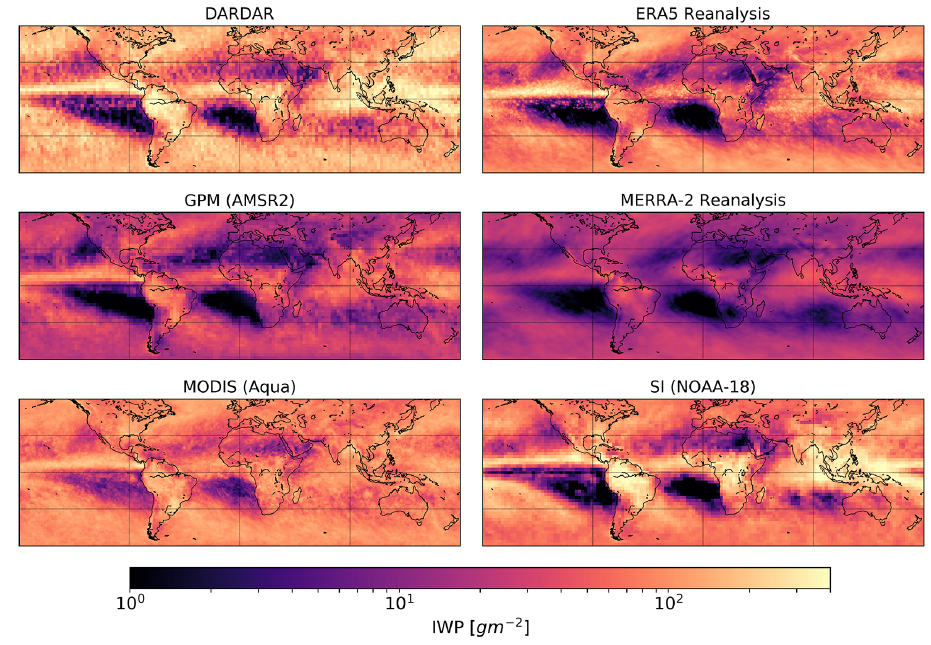
Figure 1. Global mean IWP maps from six data sets: four satellite data sets (DARDAR, GPM, MODIS, SI) and two reanalyses (ERA5, MERRA-2). 2015 data are used for all data sets except SI (2013) and DARDAR (2008–2015) due to data availability and desire for greater sampling, respectively. Daytime data were used exclusively to improve comparability with MODIS and the extended CloudSat record. Note that MERRA-2 constitutes non-precipitating ice only, whereas the other panels represent total